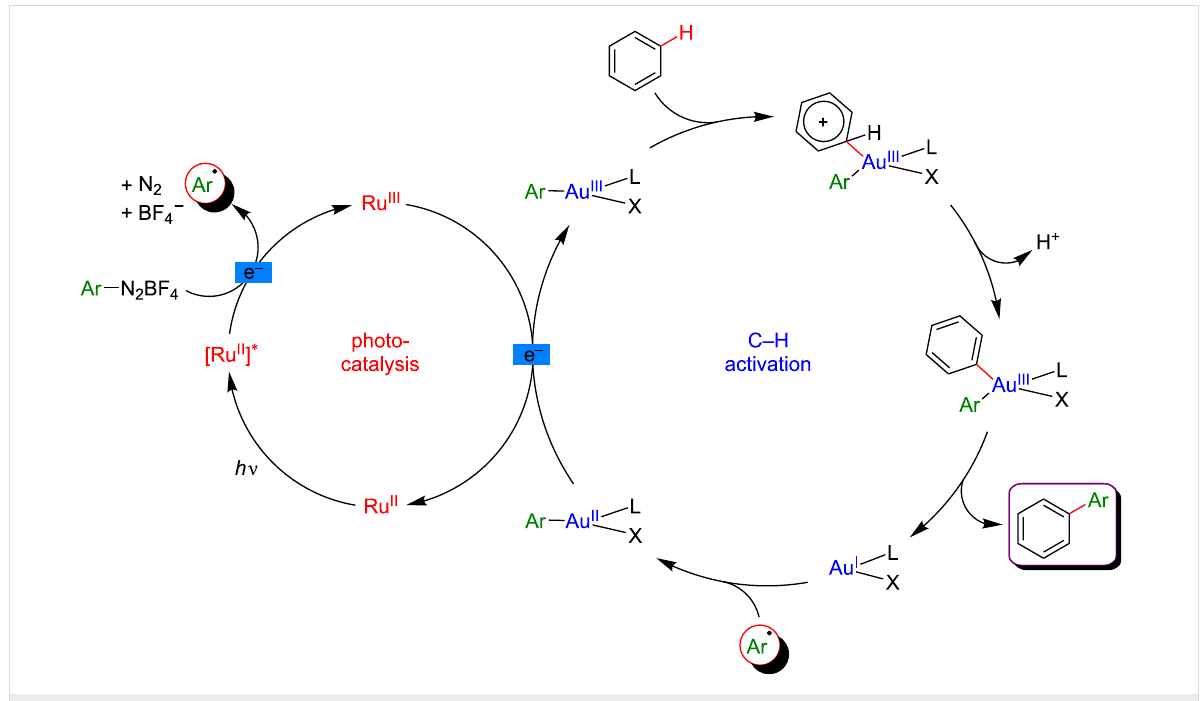
Figure 43: Proposed mechanism for the undirected C–H aryl–aryl cross-coupling via dual catalysis.